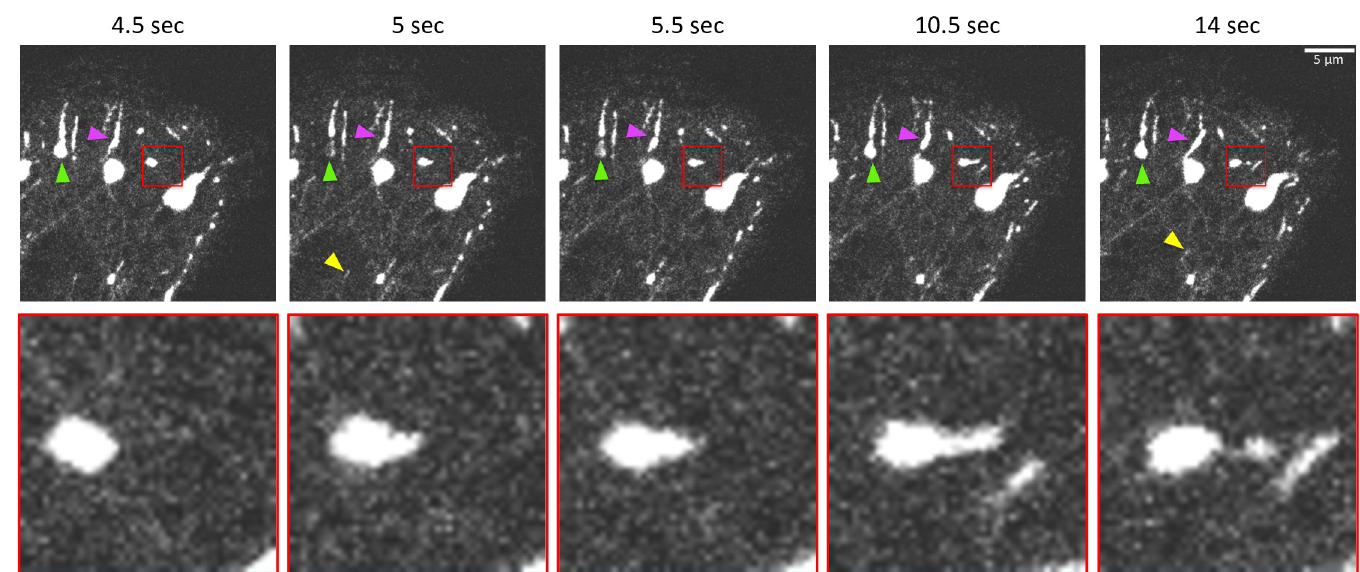
Fig 3. Dynamic behaviors of CLIP-170 patches in vivo . NIH3T3 cells were transfected to overexpress GFP-CLIP-170, and the behavior of GFP-CLIP-170 in vivo was recorded by confocal microscopy after 24–27 hr of transfection. Red box: An example of an apparent elastic deformation of a patch, following by fission (blow-up of this region is shown below). Arrows indicate examples of patch fusion (magenta), a photobleached site (green, relevant to discussions below), and a typical comet-shaped +TIP localization on a MT tip (yellow).